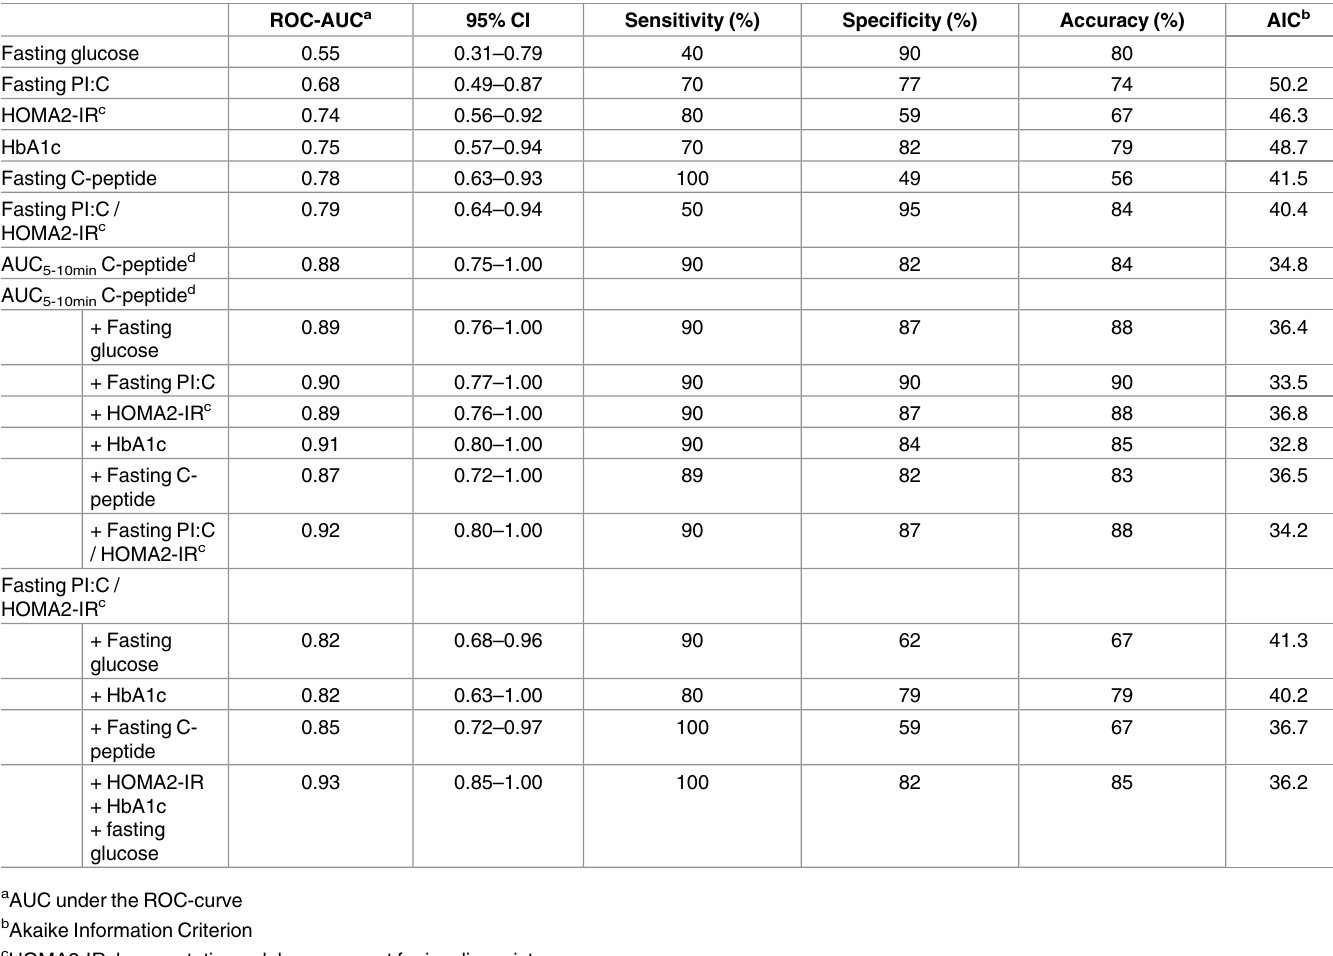
Table 4. Receiveroperating characteristic (ROC) analysis for prediction of progression to diabetes within 2 yearsin high autoantibody-inferred risk (HR) (IA-2A + or ZnT8A + plus (cid:21) 1 other autoantibody) [9].